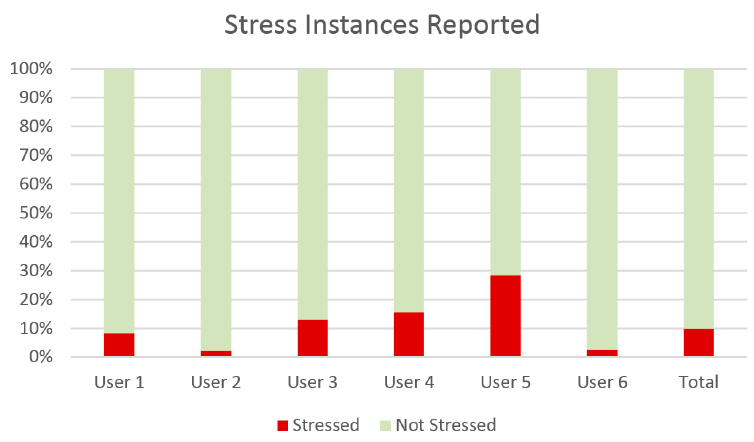
Figure 4. Class distribution in the dataset as a percentage of instances of stress reported in observation notes out of the total hours logged. notes out of the total hours logged.